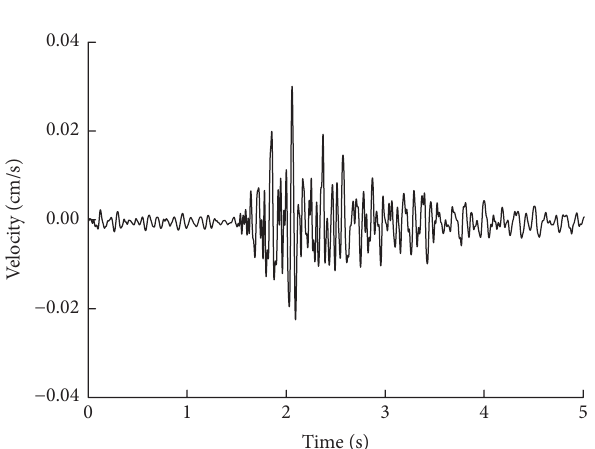
Figure 8: Relationship between relative compressive strength and age of C55 concrete Figure 9: Curve of measured blasting vibration wave at 4#